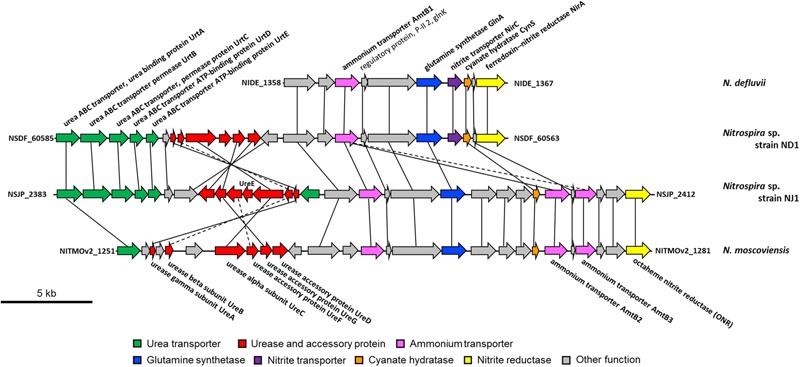
Schematic representation of the genomic regions in Nitrospira defluvii, strain ND1, strain NJ1, and Nitrospira moscoviensis containing the genes encoding the urea transporter, urease, urea accessory protein, ammonium transporter, glutamine synthetase, nitrite transporter, cyanate hydratase, and nitrite reductase. Solid lines connect homologous genes that encode proteins sharing sequence similarities above 50%. Dashed lines connect genes that encode proteins sharing sequence similarities between 30 and 50%.